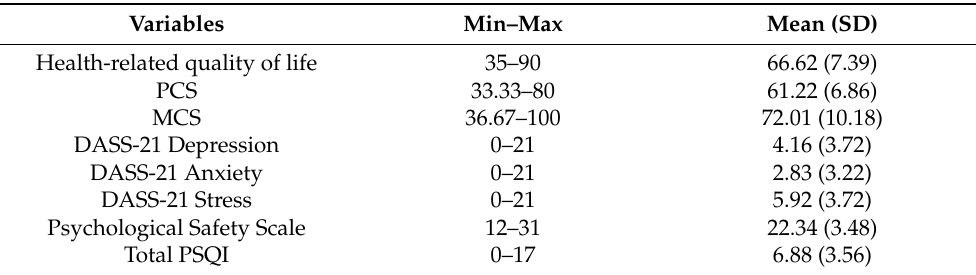
Table 2. Scores for DASS-21, psychological safety, sleep quality, and health-related quality of life ( N = 301).